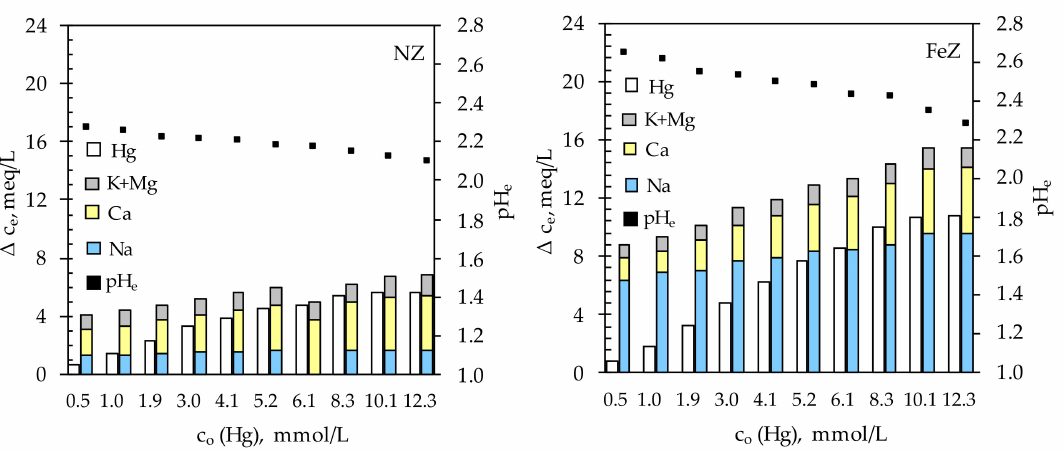
Figure 8. The relation between sorbed Hg(II) ions and released exchangeable cations and pH e in function of initial Hg(II)